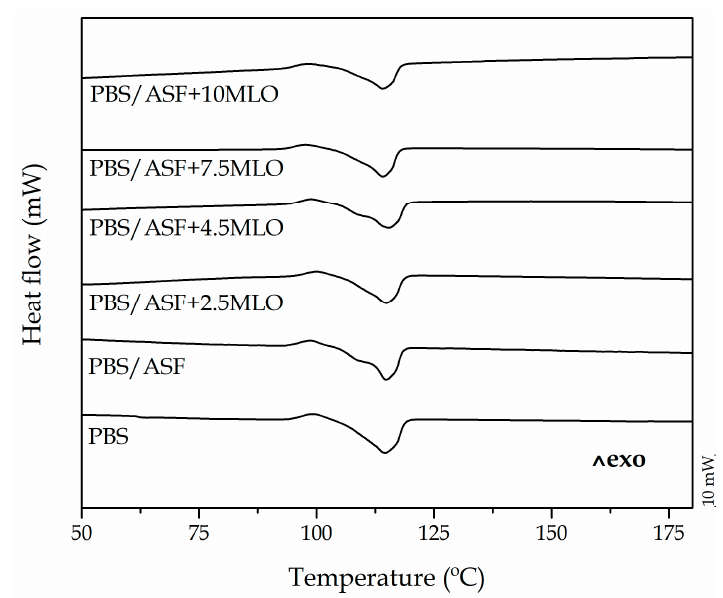
Materials 2019 , 12 , x FOR PEER REVIEW Figure 2. Differential scanning calorimetry (DSC) thermograms of neat PBS, uncompatibilized PBS/ASF composite, and PBS/ASF composites compatibilized with different MLO loading.